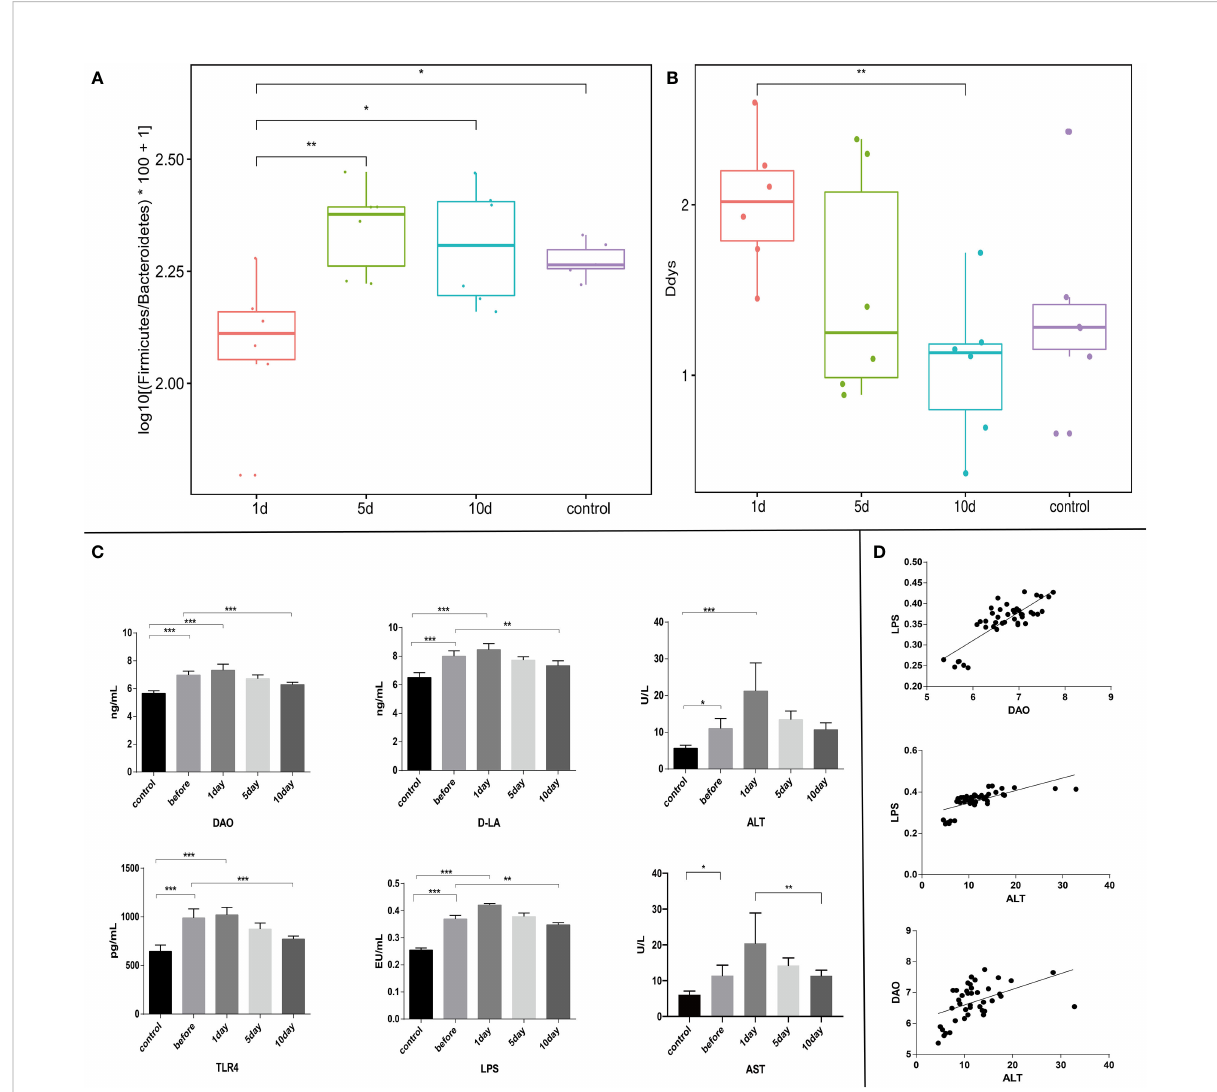
FIGURE 4 (A) and (B) Different evaluation methods were used to measure disturbance levels in intestinal fl ora (3). Intestinal fl ora disturbance peaked on the day after surgery, with no signi fi cant differences in intra-group comparisons. (C) Serum LPS, TLR4, DAO, D-LA, ALT, and AST levels. (D) Correlation analyses between serum levels of DAO and LPS ( r =0.82, p ≤ 0.05), ALT and LPS ( r =0.68, p ≤ 0.05), and ALT and DAO ( r =0.48, p ≤ 0.05). ***p < 0.001; **p <0.01; *p <